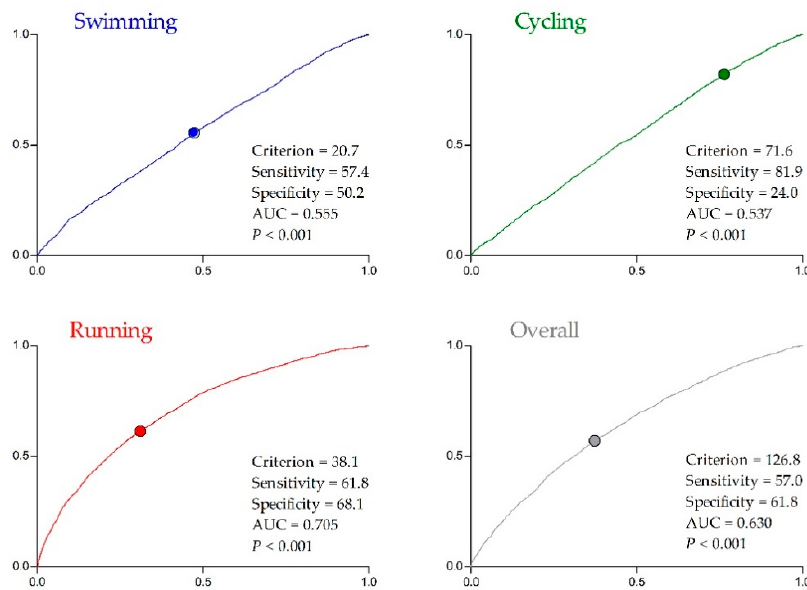
Figure 4. Receiver operating characteristic curve (sensitivity: y -axis; specificity: x -axis) according to the top three female rank positions of each trait of triathlon (Draft period: 2000–2019): AUC = area under the curve.